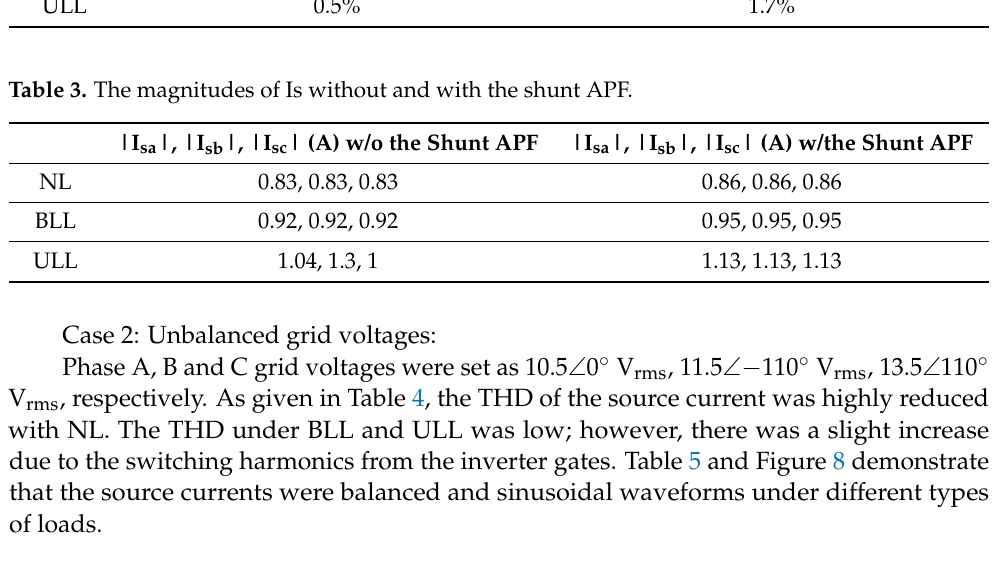
Table 4. THD of I s without and with the shunt APF.